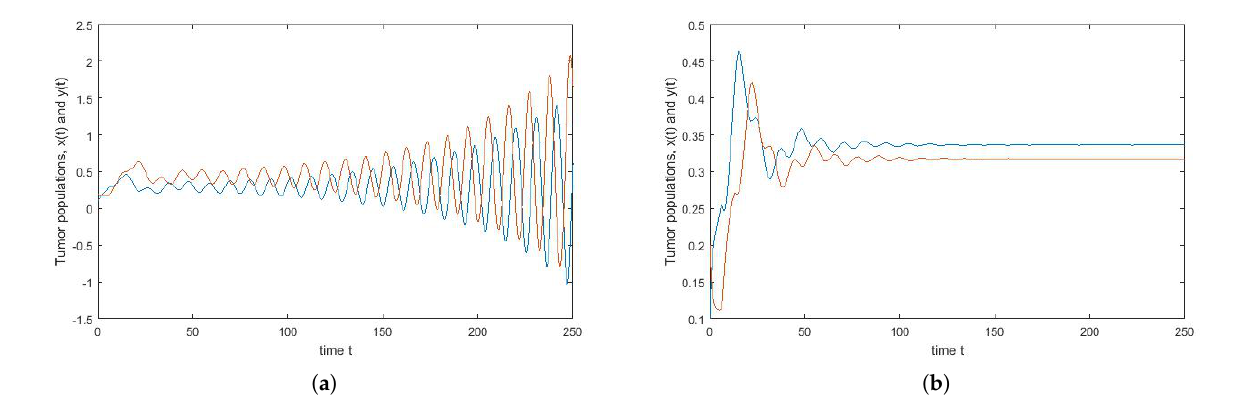
Figure 19. Simulation results of tumour populations (interphase, x ( t ) and mitosis, y ( t ) ) when τ = 5.99. ( a ) a 1 = 1.2; ( b ) a 1 =